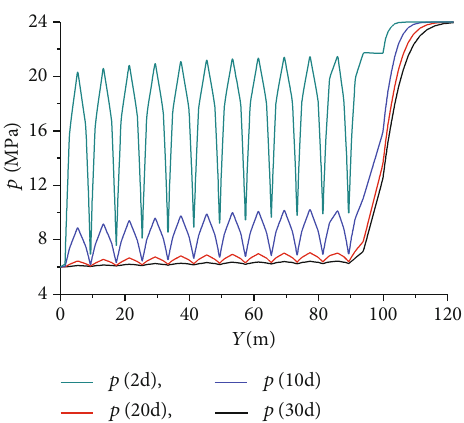
Figure 5: Pressure distribution along line E-E in Figure 4(a) (at the x = 4m plane) at di ff erent times in the fracture area of the lattice- like fracture model